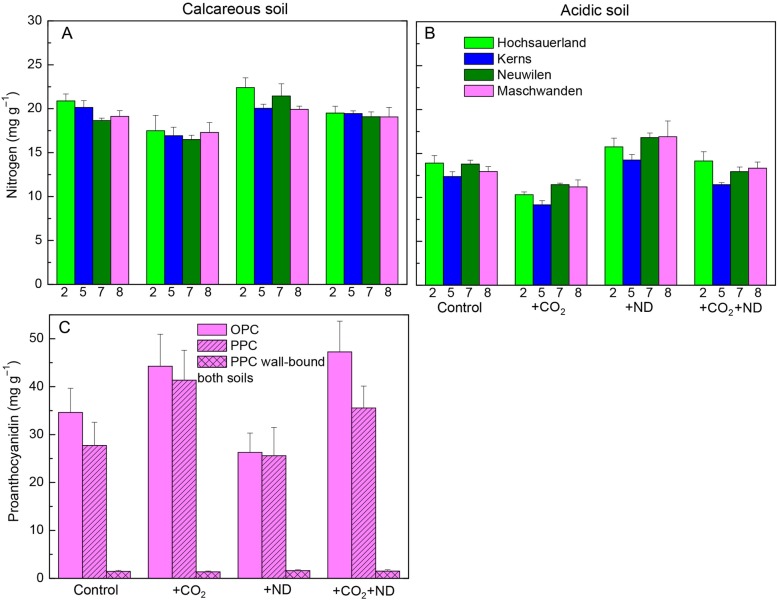
Change in the concentration of nitrogen (A and B) and PC (C) oligomers (OPC) and polymers (PPC) in September in response to +CO2, +ND and +CO2 + ND versus control, within the foliage of several spruce origins (bar colours = Fig. 5, C: origin number 8 only) growing on either acidic or calcareous forest soil (C: soil types without effect, data pooled) (mean values + SE, A and B: N = 4, C: N = 8).